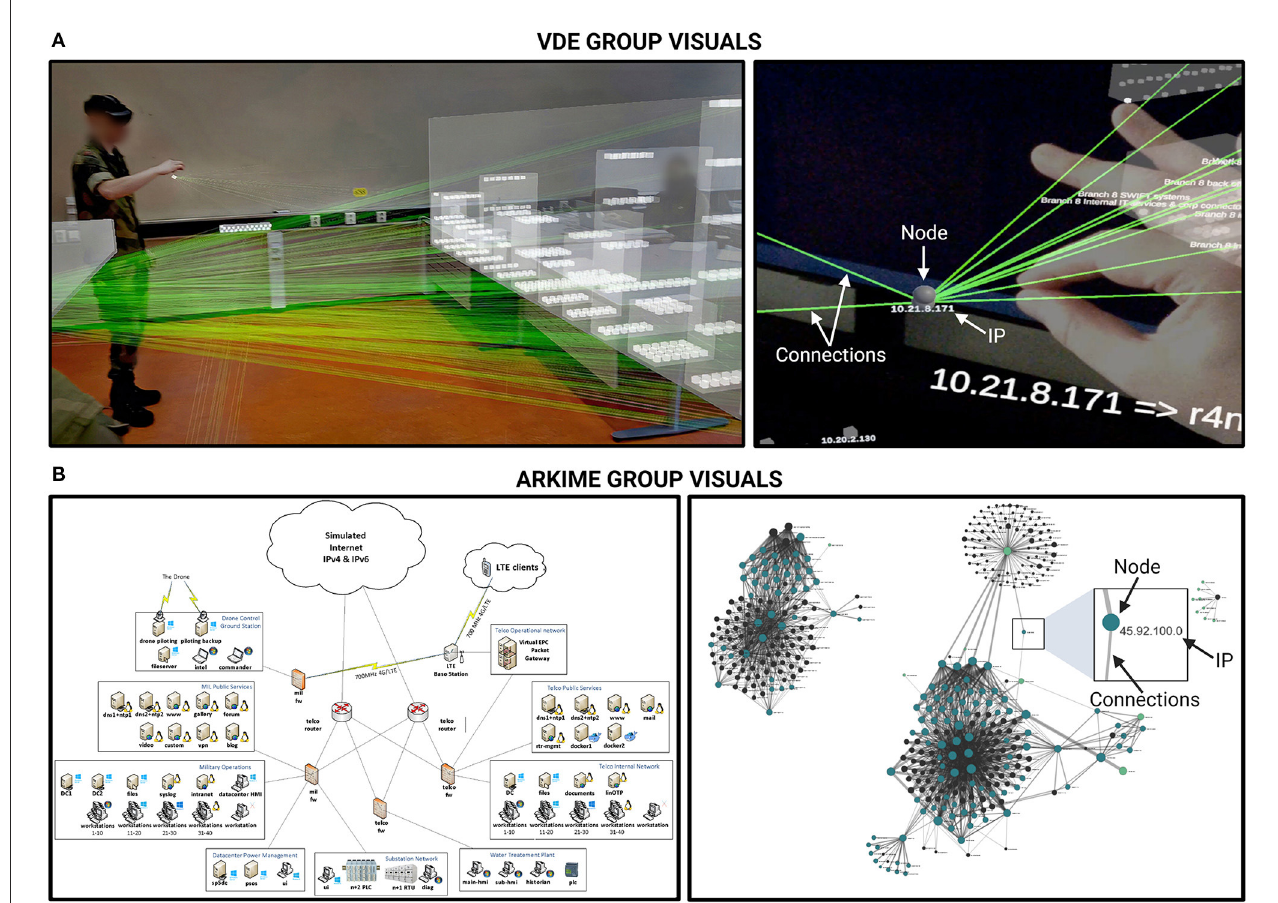
FIGURE3 Overview of the visualization tools used in each condition. (A) The Virtual Data Explorer (VDE) representation of the network topology. The first image in the panel (left-hand side) depicts an overview of the network layout used in the present study. The second image (right-hand side) is a representative close-up (taken from Kullman and Engel, 2022a). White arrows have been superimposed on the image on the right to indicate node/hosts, edges that represent connections between nodes, and the host IP address. (B) Images depicting the 2D network topology as shown in the Arkime condition. The first image in the panel (left-hand side) depicts an approximation of the 2D representation of network topology as shown in the paper schematics. The second image (right-hand side) depicts a graph representation of the network topology as shown in the Arkime software, where dots are hosts and edges are the connections between them. Participants could zoom in, select nodes to see exclusive connections, session number, and so on. Black arrows have been superimposed on the image on the right to indicate node/host, edges that represent connections between nodes, and the host IP